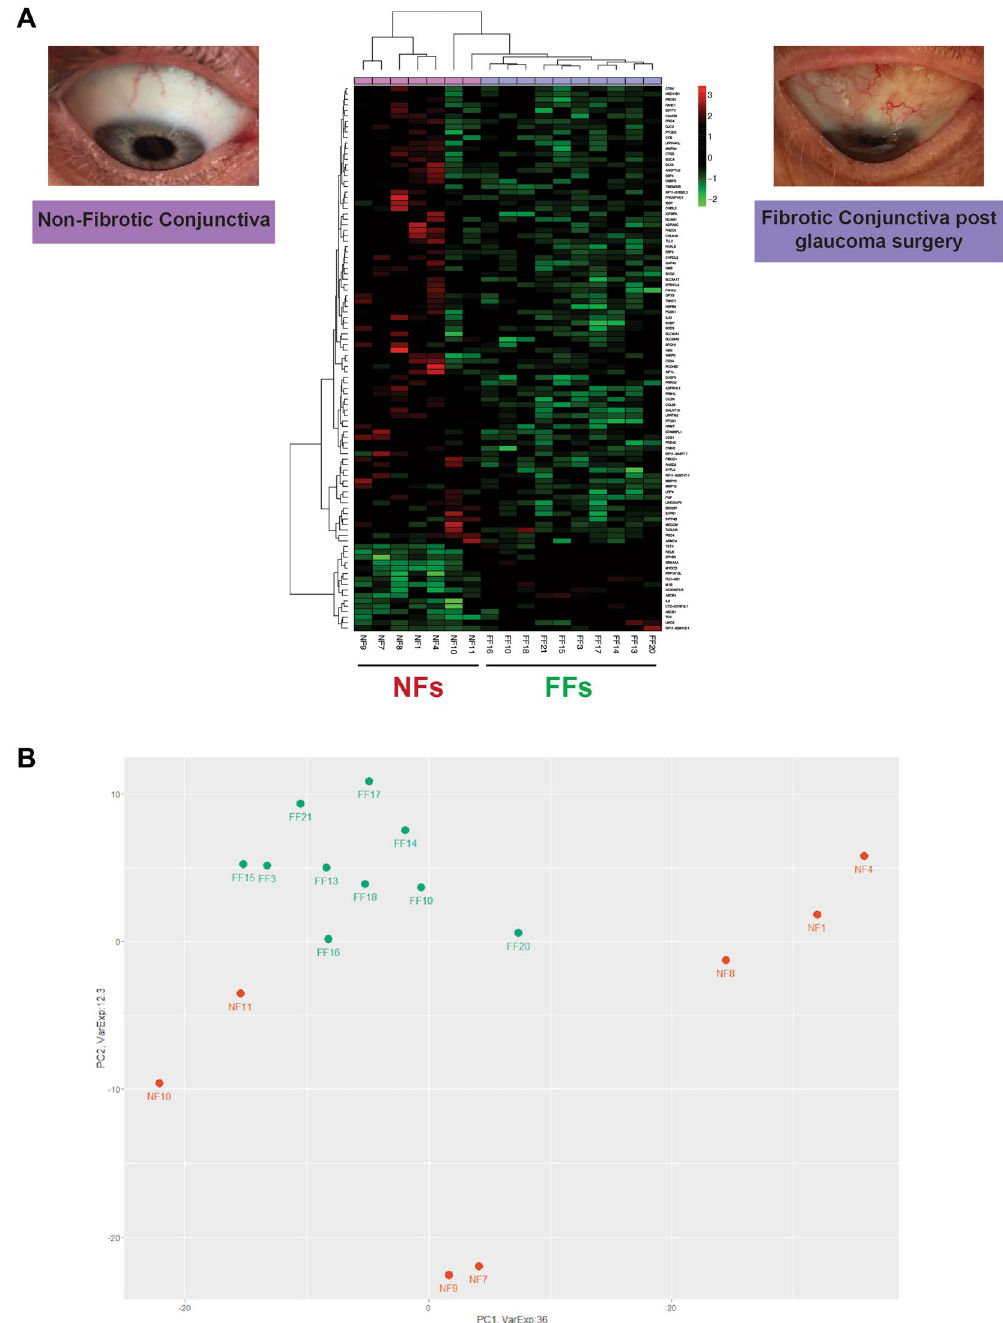
Figure 1. ( A ) Heat map of differentially expressed genes between FFs and NFs. The 100 genes shown in the heat map were selected as being the most significant changes, i.e. sorted by p values with the smallest and most significant at the top. The genes were clustered using hierarchical average linkage clustering and euclidean distances using the R package for Nonnegative Matrix Factorization (NMF) 75 . ( B ) Principal component analysis (PCA) was performed using DESeq2 on the regularised log transformed count